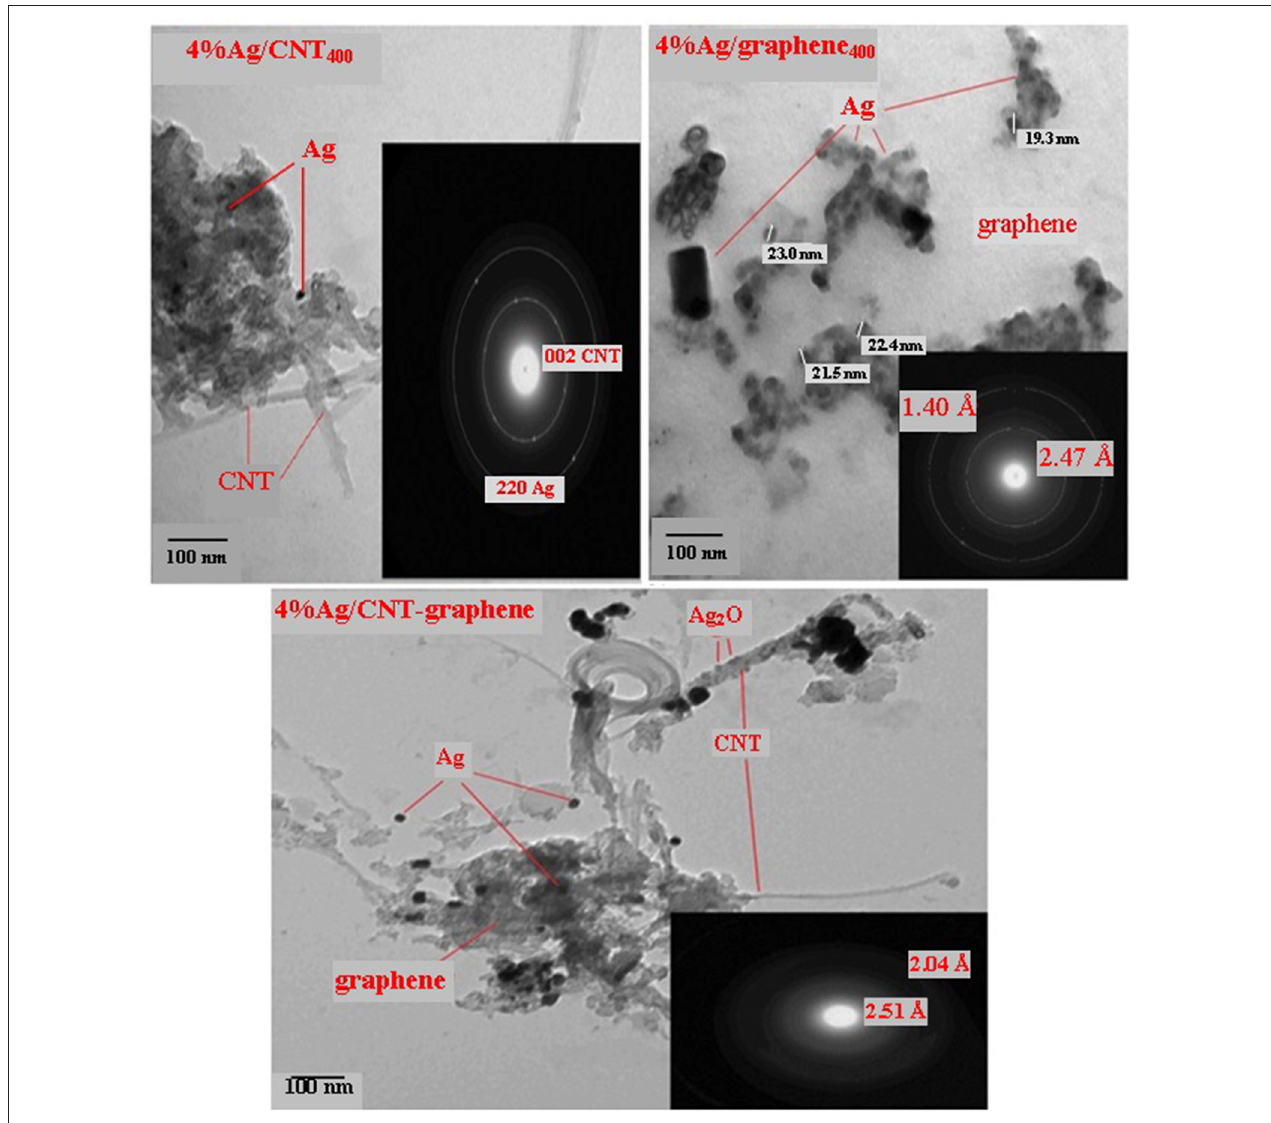
FIGURE 2 | TEM and SAED images (in-sets) of 4%Ag/CNT 400 , 4%Ag/graphene 400 , and 4%Ag/CNT-graphene 400 .